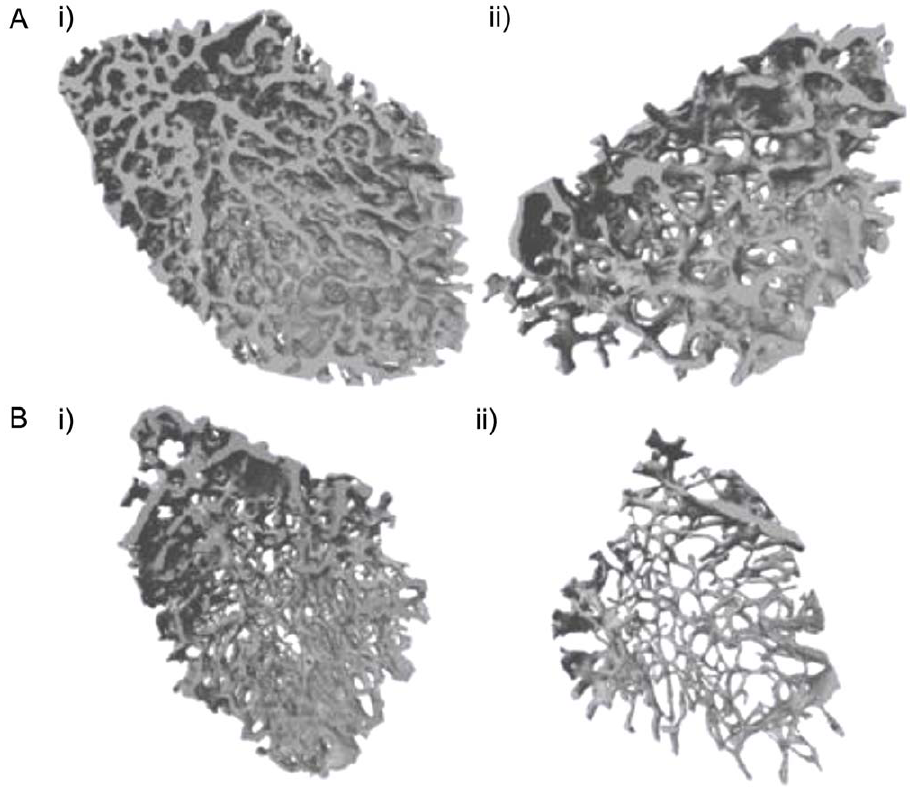
Figure 2. 3D reconstruction of the trabecular bone scanned using microCT. (A) Wild-type and (B) Enpp1 2 / 2 mice femurs were collected at i) 6 weeks and ii) 22 weeks of age. These reconstructions illustrate the reduction of trabecular number in the Enpp1 2 / 2 mice.